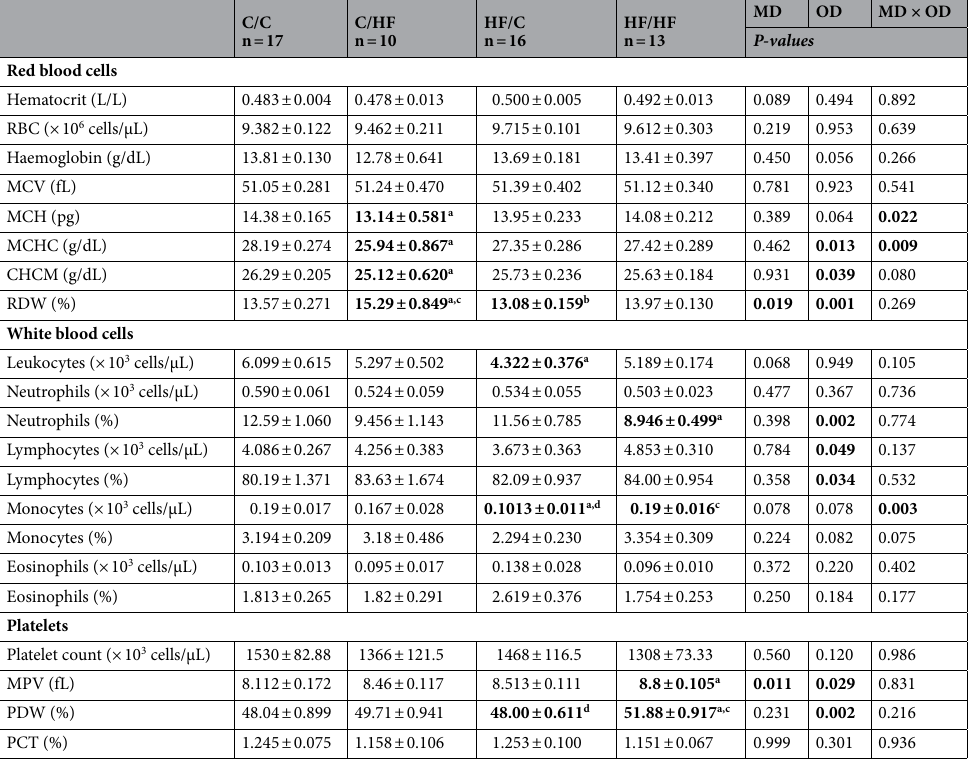
Table 2. Maternal and offspring high-fat diet leads to increased platelet volume of male offspring. Data presented as mean ± SEM. N = 10–17 animals from 7–9 litters per group. Groups were analyzed by Two- way ANOVA and Tukey’s post-test for multiple comparisons. Bold values depict statistical differences. The interaction between the two variables denotes that the effect of one variable is dependent on the other. C/C dam and offspring fed standard laboratory diet; C/HF dam fed standard laboratory diet and offspring fed high-fat diet; HF/C dam fed high-fat diet and offspring fed standard laboratory diet; HF/HF dam and offspring fed high fat diet, MD maternal diet, OD offspring diet, MDxOD interaction between MD and OD, RBC red blood cells, MCV mean corpuscular volume, MCH mean corpuscular haemoglobin, MCHC mean corpuscular haemoglobin concentration, CHCM cell haemoglobin concentration, RDW red cell distribution width, MPV mean platelet volume, PDW platelet distribution width, PCT plateletcrit. a p < 0.05 vs C/C. b p < 0.05 vs